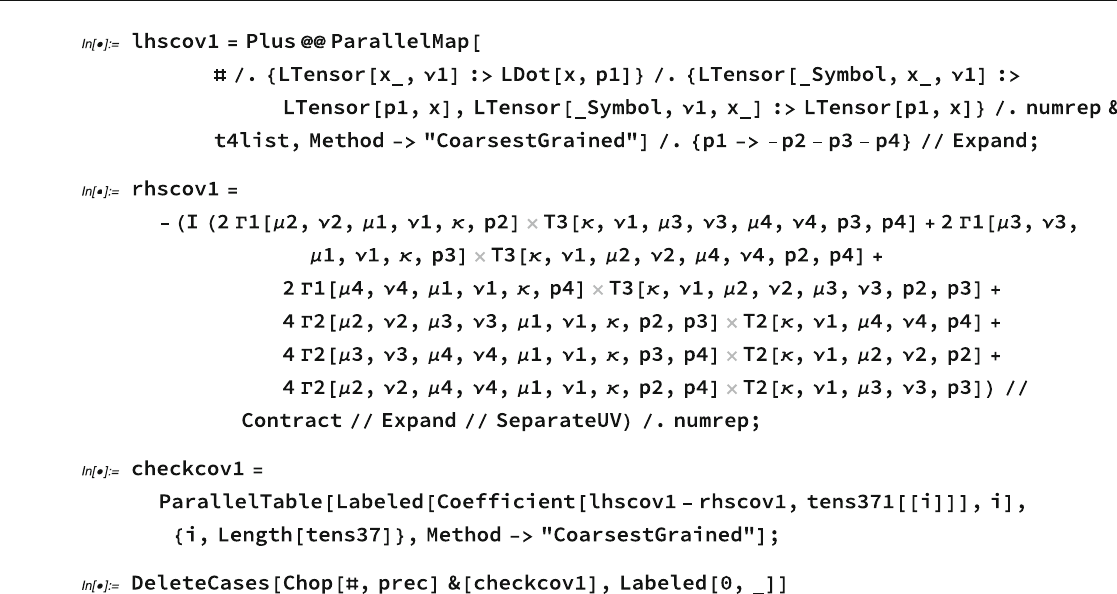
Fig. 8 Parallelized numerical comparison of the scalar coefficients over all the tensors in the base tens371 (3 momenta, rank 7, indices assignments for the 1st identity) of the lhs and rhs of the first transverse